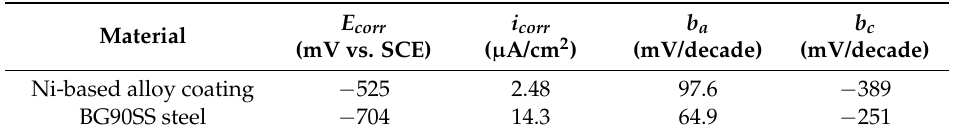
Figure 3. Polarization curves of the test materials in the simulated formation water at 25 °C and 0.1 MPa H 2 S/CO 2 . Table 4. Electrochemical parameters obtained from the polarization curves of the test materials in the simulated formation water at 25 °C and 0.1 MPa H 2 S/CO 2 .